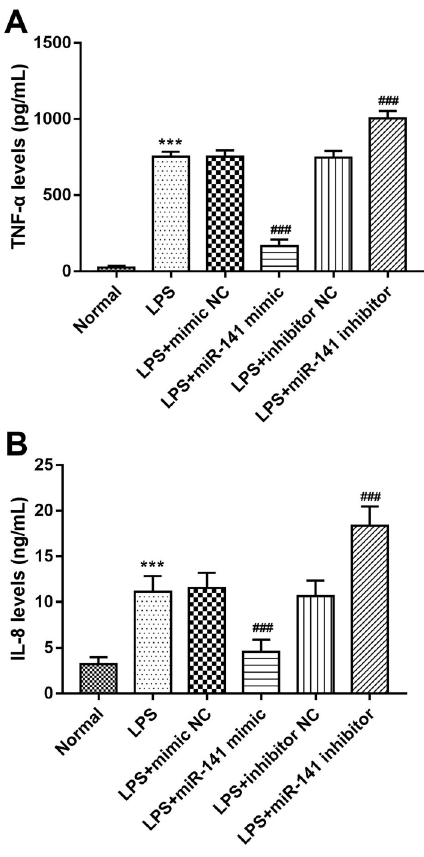
Figure 4 . Effects of miR-141 on LPS-induced in fl ammatory response in monocytes. LPS treatment increased TNF- a ( A ) and IL-8 ( B ) levels, and this effect was weakened by the overexpression of miR-141 and enhanced by the reduction of miR-141 in monocytes. Data are reported as means ± SD. ***P o 0.001 compared with normal group; ### P o 0.001 compared with LPS group Figure 3B, the relative luciferase activity was inhibited by the overexpression of miR-141, but was enhanced by the knockdown of miR-141 in the WT group (both P o 0.05, Figure 3B). However, no signi fi cant luciferase activity changes were observed in the MUT group (all P 4 0.05).